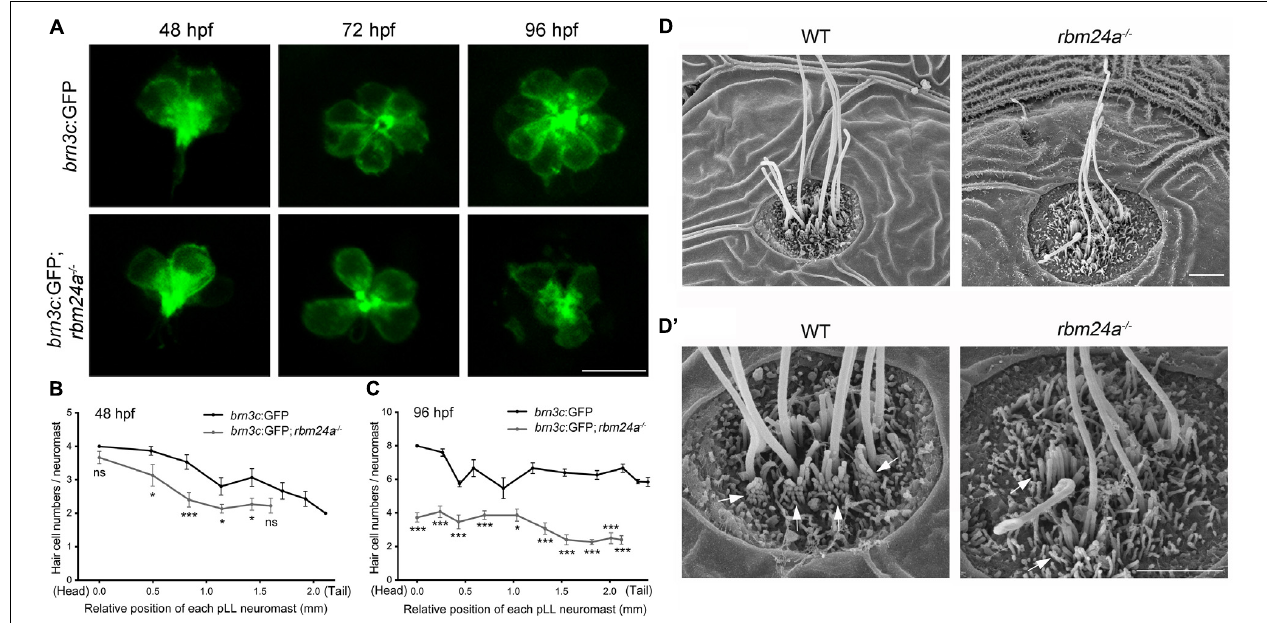
FIGURE 5 | Development of pLL hair cells is affected in rbm24a mutants. (A) Confocal microscopic imaging analysis of pLL neuromasts in wild-type or rbm24a mutant brn3c :GFP line at different developmental stages as indicated. (B,C) The numbers of GFP-positive hair cells of each pLL neuromasts at 48 and 96 hpf are calculated according to the results from (A) . The numbers of larvae for each group is 15. (D,D’) Hair bundles of pLL neuromasts at 72 hpf are examined using SEM. Stereocilia are indicated with arrows. Scale bars, 10 µ m in (A) , 2 µ m in (D,D’) . ns, not significant; * p < 0.05; and *** p <